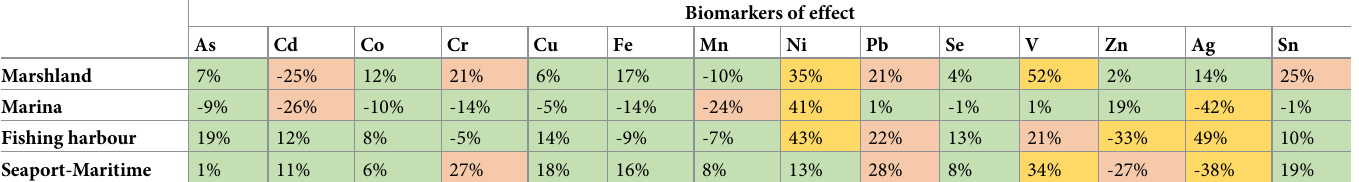
Table 2. Reliability or difference between “inter-subject” (n = 7) and “pool” studies at each site (marshland, marina, fishing harbour and seaport) at D21 for the 14 heavy metals called biomarkers of effect. Green shading represents 0–20% difference, red shading represents 20–30% difference and yellow shading represents more 30% difference. Negative percentages are lower rates in the “inter-subject” study compared to the “pool”